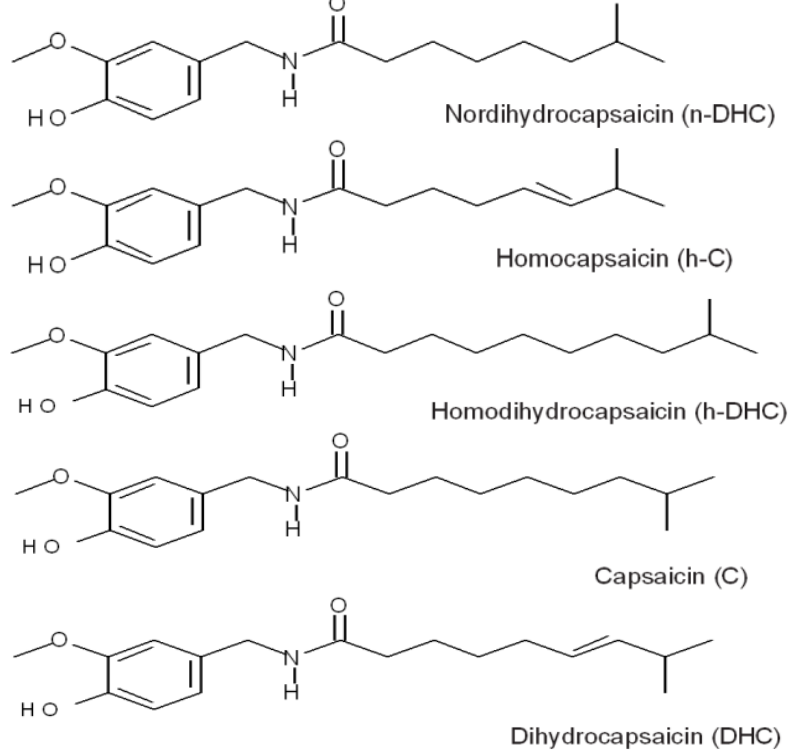
Figure 1. The chemical structures of the main capsaicinoids identified in this